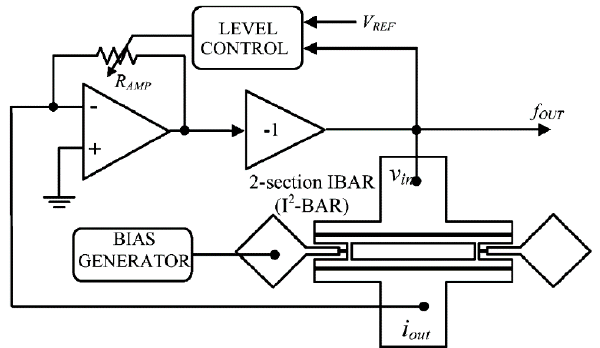
Figure 26 . The typical trans-impedance amplifier configuration providing 0° phase shift and sufficient gain around an electrostatic resonator [241]. © 2007 IEEE. Reprinted with permission from Electronically Temperature Compensated Silicon Bulk Acoustic Resonator Reference Oscillators by Sundaresan in J. Solid-State Circuits , 2007.